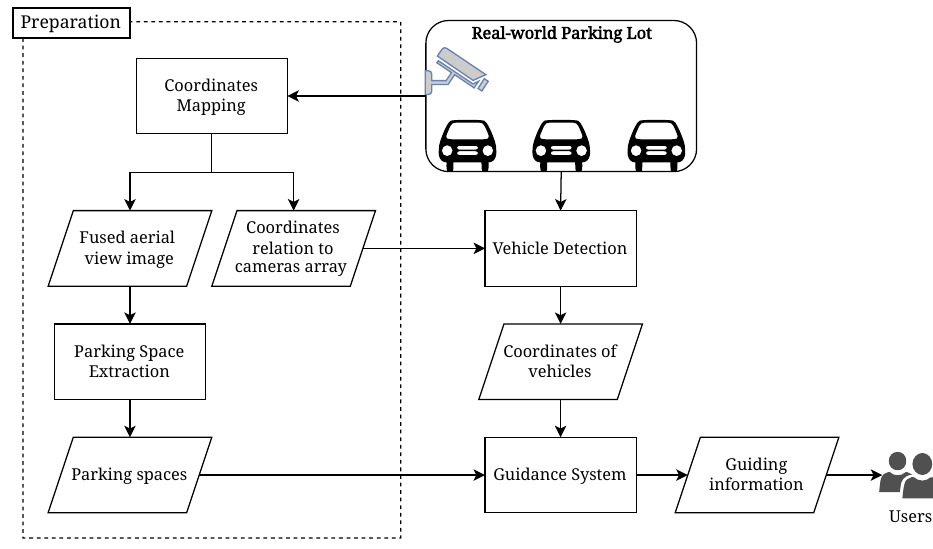
Figure 1. Overview of the system